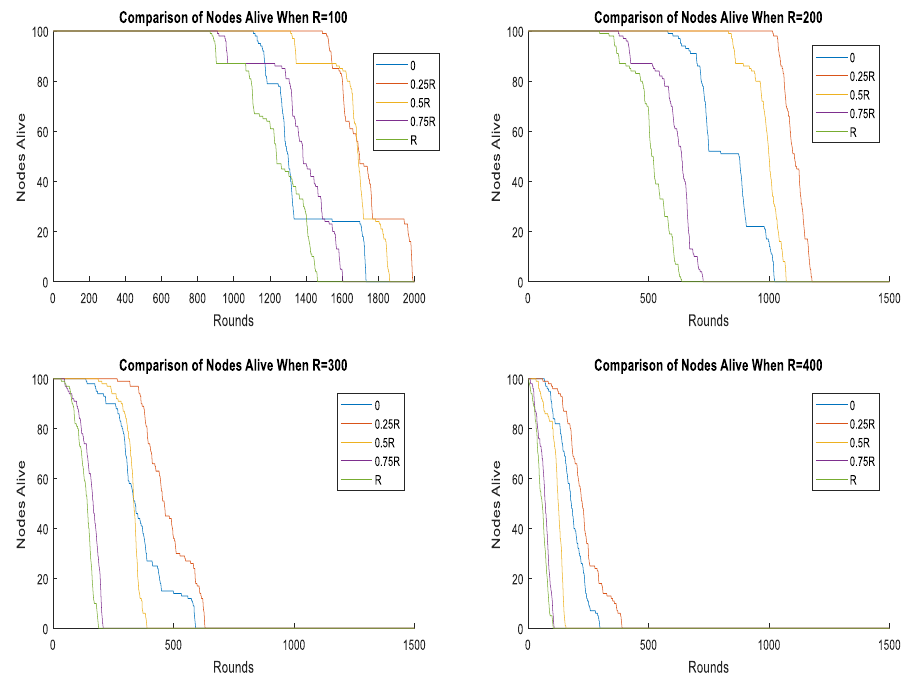
Figure 11. Different radius of mobile sink under different network size.